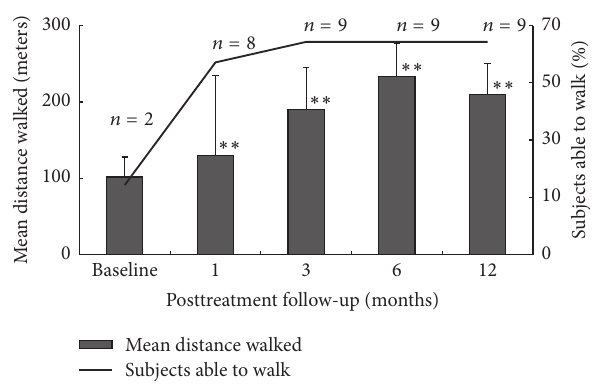
Figure 5: Analysis of 6-minute walking distance from baseline to 12 months ( ∗∗ 𝑝 < 0.01